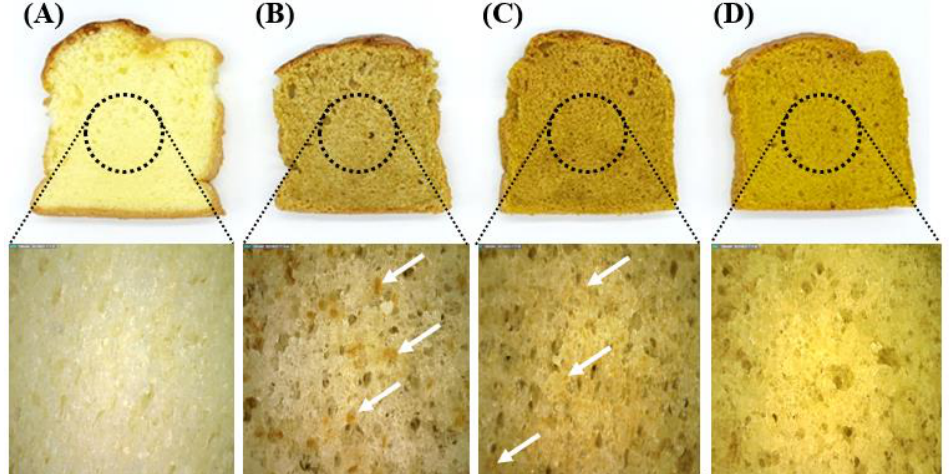
Figure 3. Photographs of sponge cake prepared with differently sized MP. ( A ) Control: sponge cake with MP. ( B ) Course MPS: sponge cake with coarse MP. ( C ) Fine MPS: sponge cake with fine MPS. ( D ) Superfine MPS: sponge cake with superfine